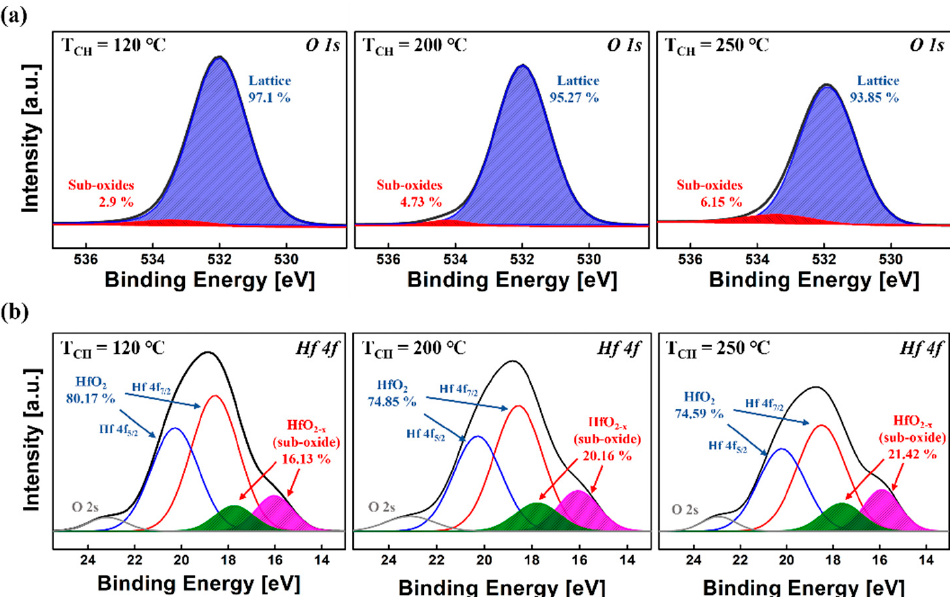
Figure 4. Measured ( a ) XPS O 1s spectra and ( b ) XPS Hf 4f spectra of the HZO film in TiN/HZO/TiN capacitor, which was fabricated at three different chamber temperatures (i.e., 120 °C, 200 °C and 250 °C). The O 1s levels were deconvoluted into two peaks, i.e., lattice oxygen peak and sub-oxide peak. The Hf 4f levels were deconvoluted into five peaks, i.e., HfO 2 peaks, sub-oxide peaks, and O 2s peak. Each intensity level was normalized to the same